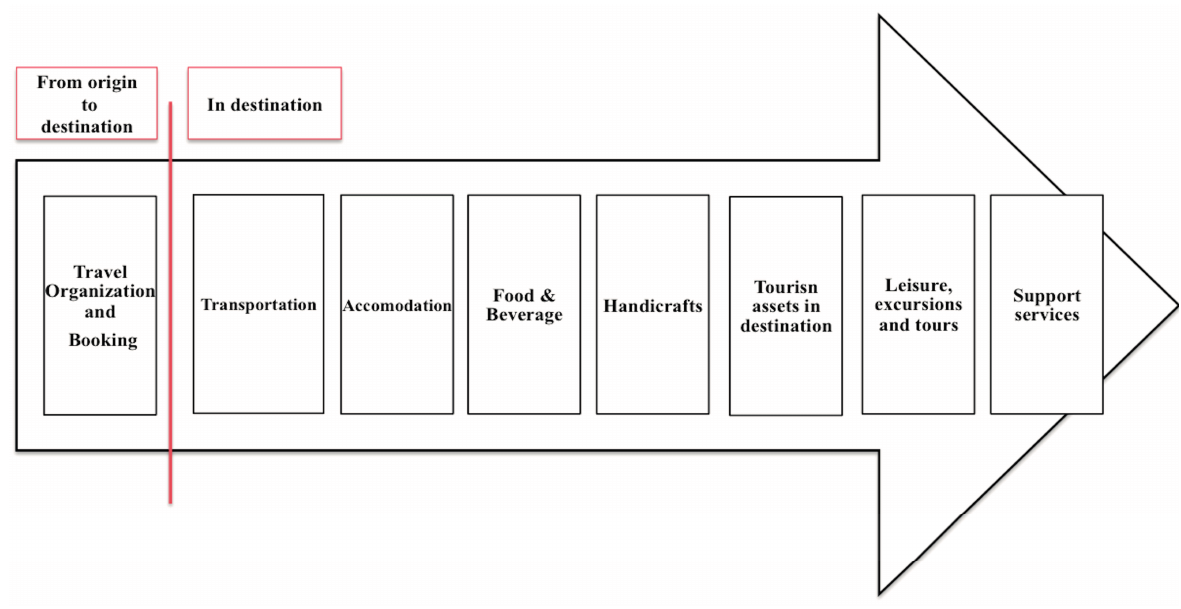
Figure 6. TVC -Tourism Value Chain (source: authors’ elaboration based on